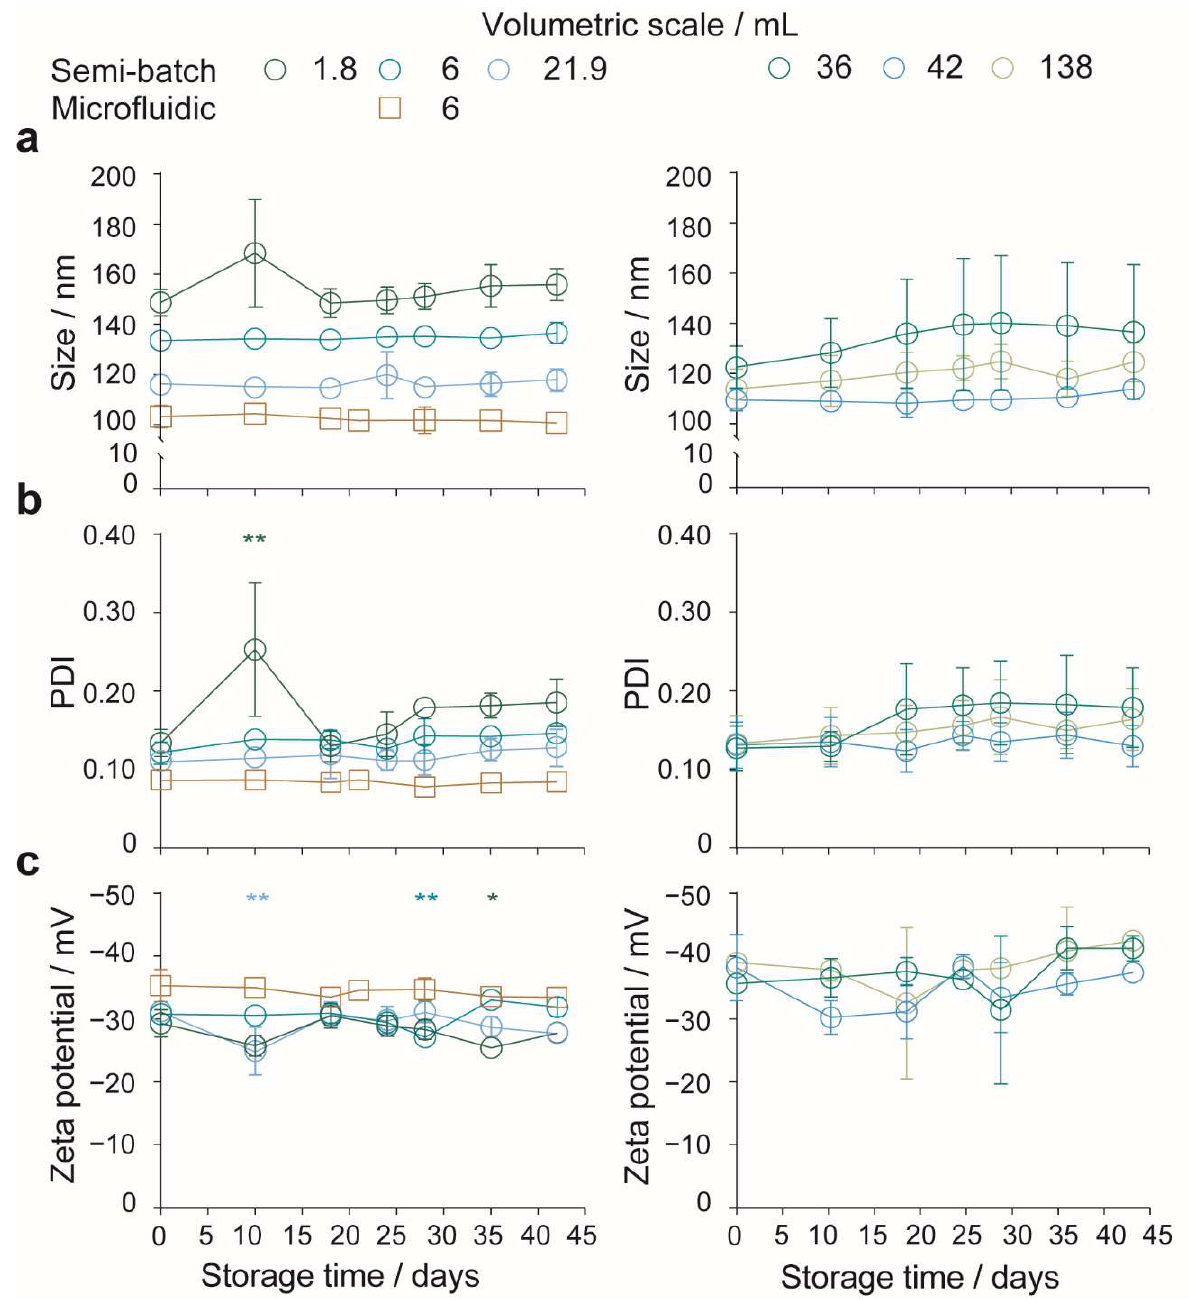
Figure 7. Stability of silk nanoparticles manufactured using drop-by-drop semi-batch and microfluidic formats at varying volumetric scales. ( a ) Hydrodynamic diameter, ( b ) polydispersity index (PDI), and ( c ) zeta potential of silk nanoparticles stored in water at 4 °C. Diluted nanoparticle suspensions were vortexed prior to DLS analysis, ±SD, n = 3. Unless otherwise stated, the silk nanoparticle stability was evaluated by one-way ANOVA followed by Dunnett’s post hoc test to compare between t = 0 day control and t > 0 day samples. The zeta potential stabilities of nanoparticles manufactured at 36- and 138-mL scale were evaluated using the Brown–Forsythe and Welch ANOVA followed by Dunnett’s T3 post hoc test. Asterisks denote statistical significance for each formulation between t = 0 and t > 0 days, determined using post hoc tests as follows: * p < 0.05, ** p <